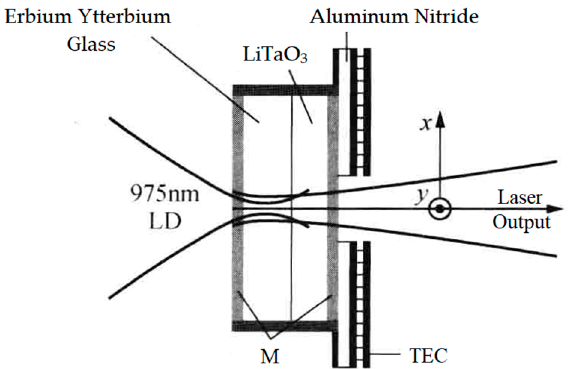
Figure 13. Schematic diagram of thermo-optical birefringent microchip dual-frequency laser [26]. LD: laser diode; M: mirror; TEC: thermo-electric cooler.